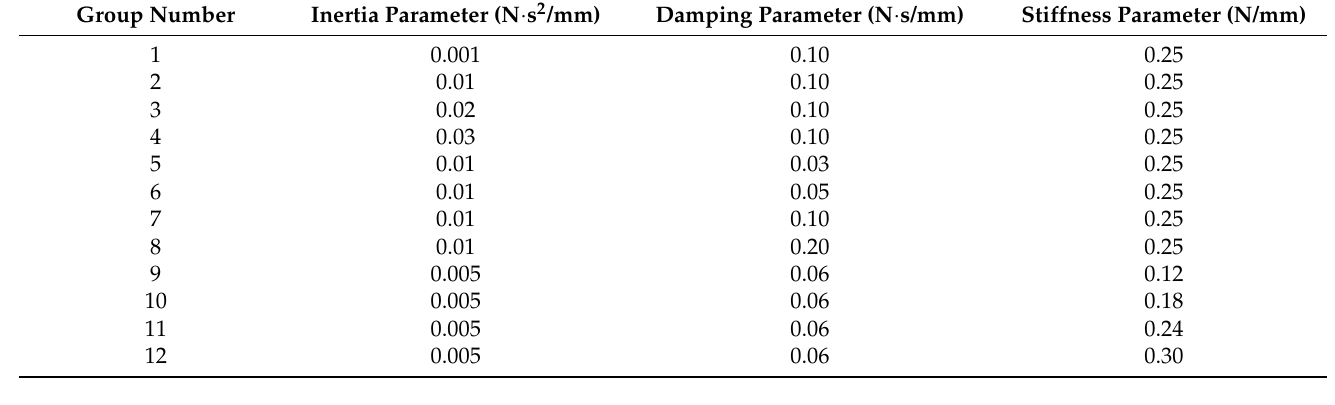
Table 2. Impedance parameter setting in the 12 groups of experiments.